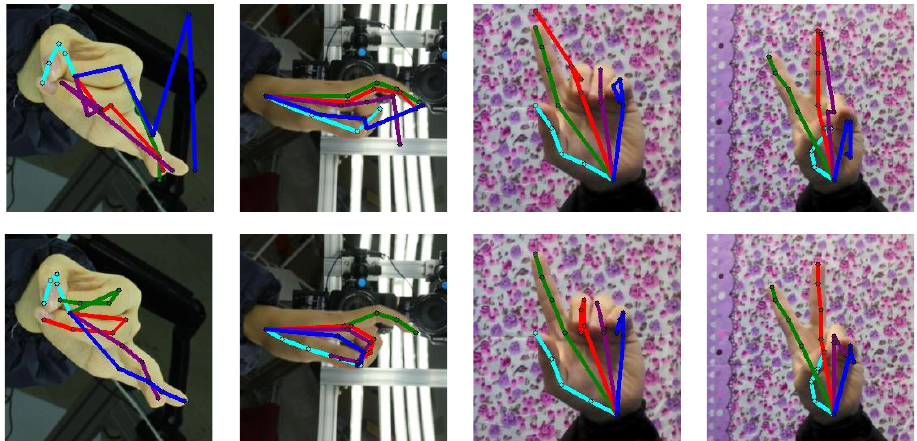
Figure 1. Some visualizations on the unlabeled target domains. The first row is the prediction results of the source-only model. The second row shows that the results of our model are more accurate. The colors indicate the estimated skeletons of different